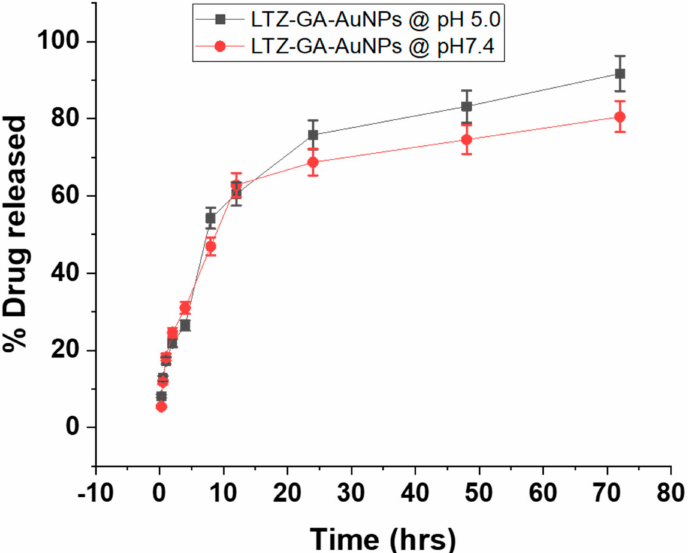
Figure 3. In vitro cumulative percentage drug release study of LTZ @ GA-AuNPs pH = 5 and 7.4 at 37 ◦ C.